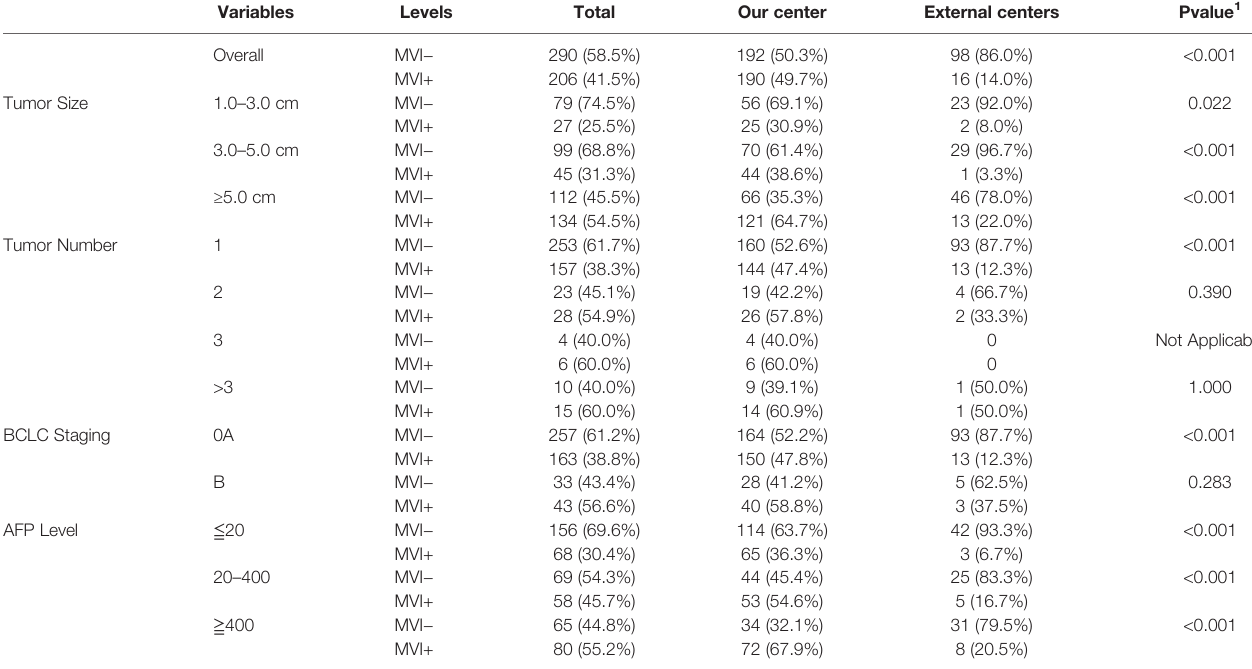
TABLE 2 | Subgroup analysis for prospective cohort (our center vs. external centers). Variables Levels Total Our center External centers Pvalue